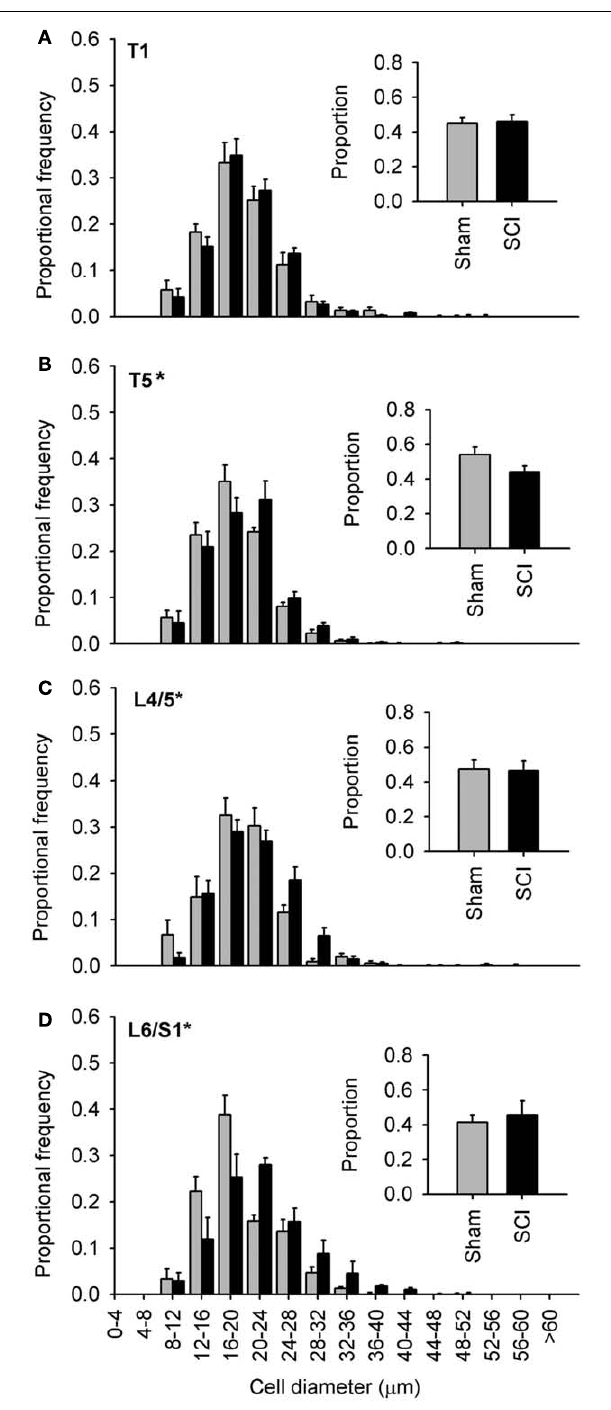
FIGURE 4 | Capsaicin-sensitive dorsal root ganglion neurons increased in diameter caudal to, but not rostral to, high-thoracic spinal cord injury. (A–D) Size-frequency distributions ofTRPV1-positive neurons from a rostral DRG (T1) and caudal (T5, L4/L5, L6/S1) DRGs, harvested 1month after sham- (gray) or completeT3 SCI (black).The increase in size is the most pronounced in the most caudal ganglia. Proportions ofTRPV1-positive neurons at each level are shown in the insets (A–D) . Asterisks indicate P < 0.05, K–S goodness-of-fit